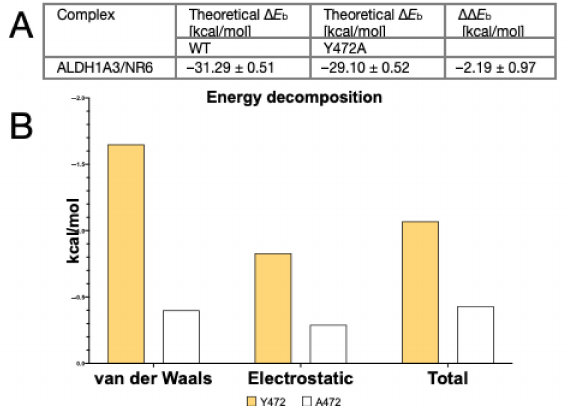
Figure 4. ( A ) Table of MM-GBSA-Alanine scanning theoretical affinity of ALDH1A3/NR6 complex. ( B ) Energy contribution of residue 472 to the predicted theoretical affinity of NR6 in the WT (yellow) and Y472A mutant (white)